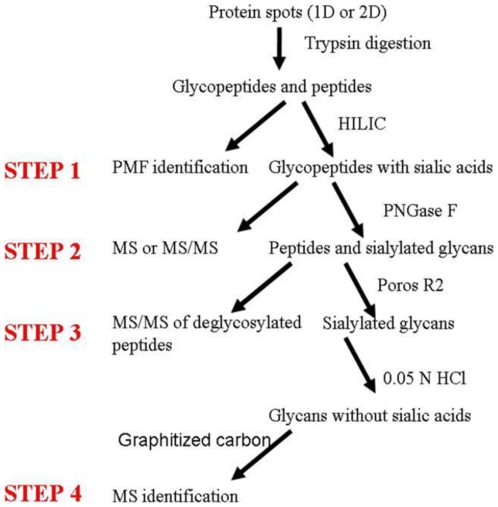
The strategy for N-glycosylation analysis of gel-separated sialylated glycoproteins.